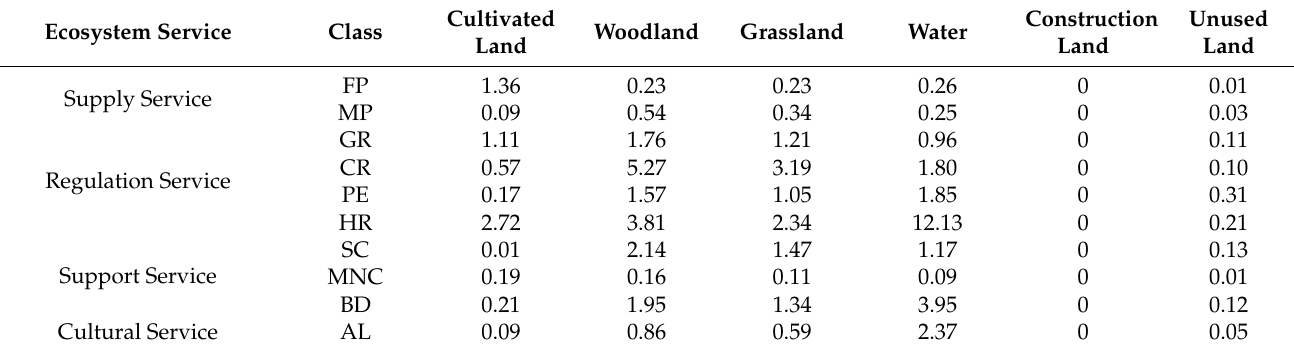
Table A4. Equivalent factors of ecosystem service value